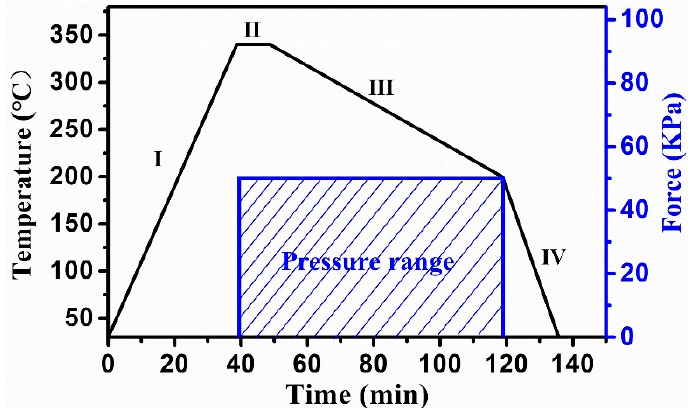
Figure 2. Schematic diagram of the molding process. I: heating; II: pressing; III: slow cooling; IV: rapid cooling.